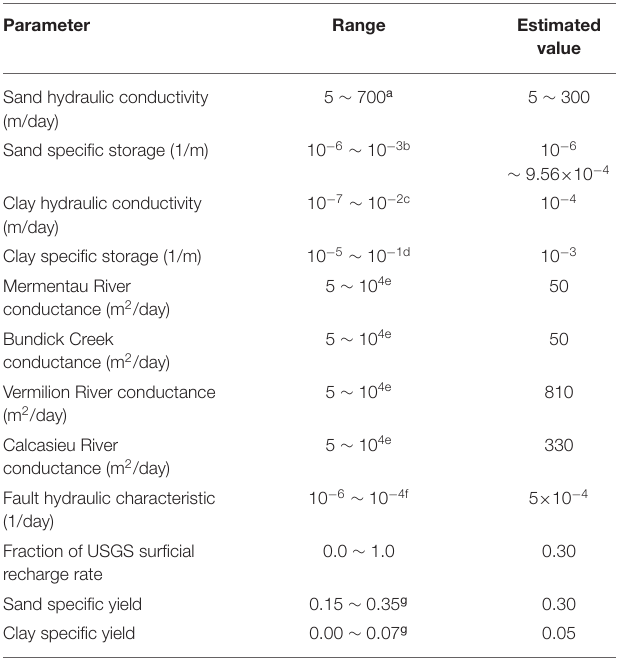
TABLE 1 | Ranges and estimated parameter values for the Chicot groundwater model. Parameter Range Estimated